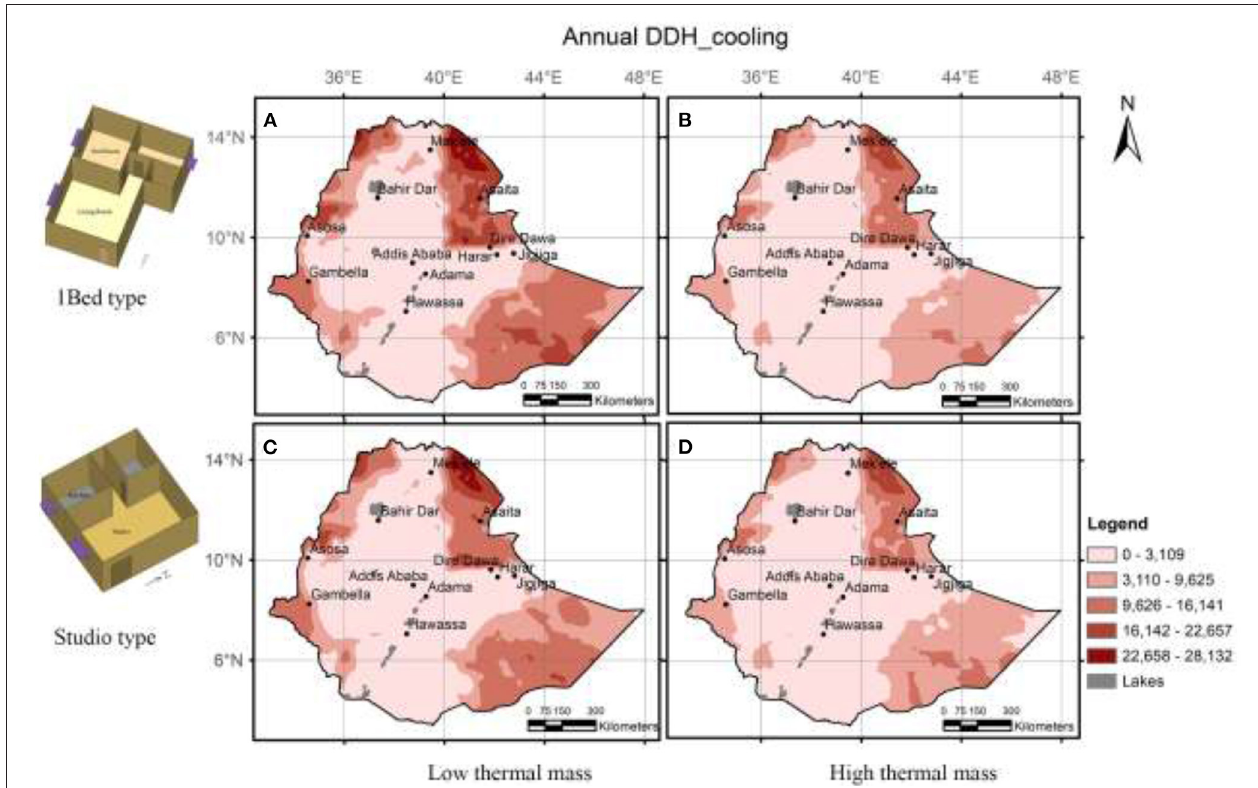
FIGURE 9 | Maps of annual total cooling degree discomfort hours (A) case 1a, (B) case1b, (C) case 2a, and (D) case 2b.